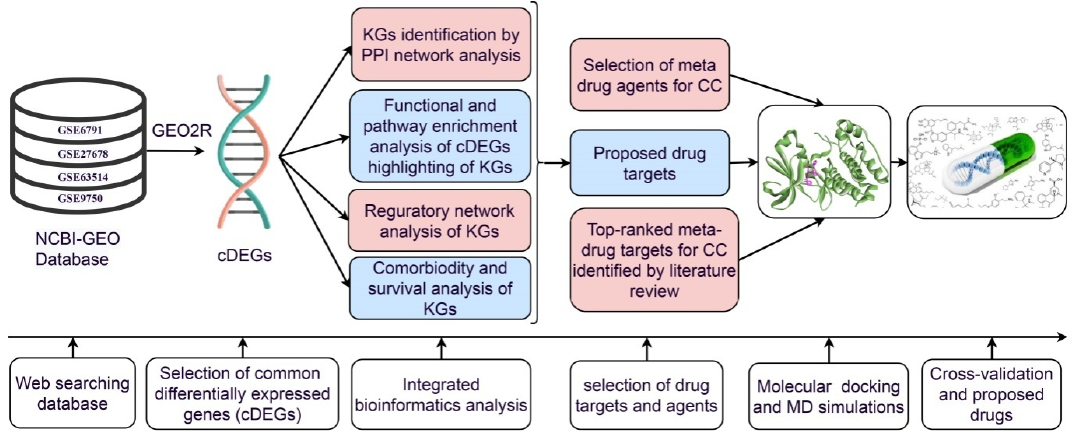
Figure 1. The pipeline of this study.